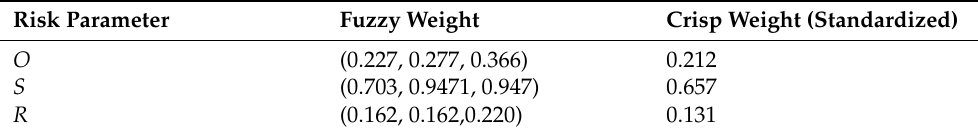
Table 9. Risk parameters’ fuzzy and crisp weights.